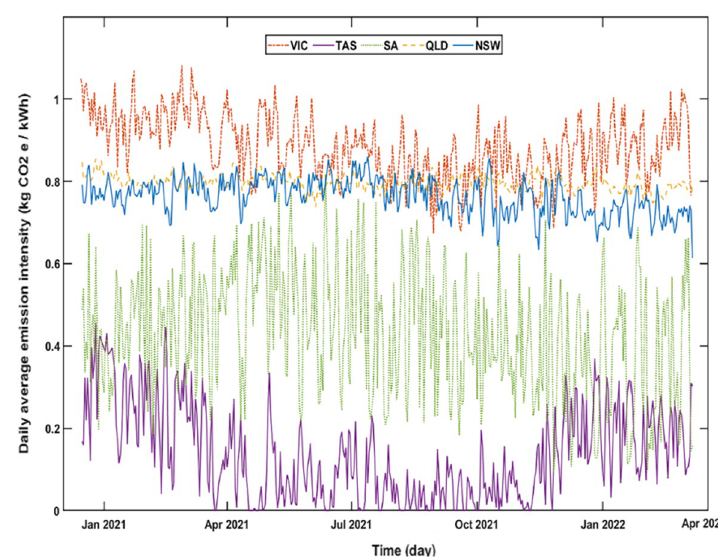
Fig. 4 Daily average emission intensity of NEM regions between January 2021 and March 2022